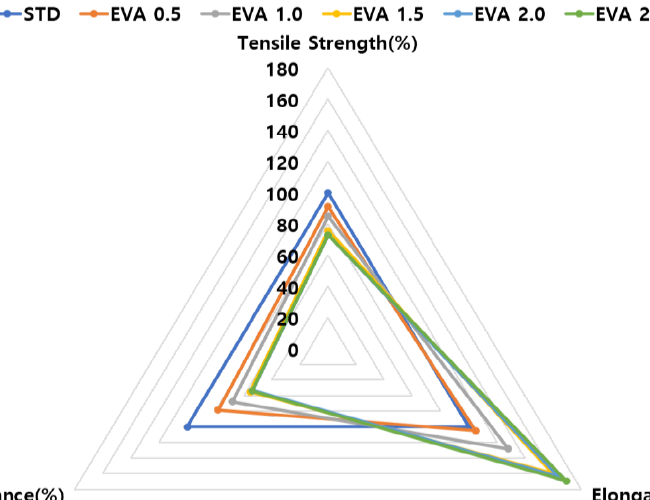
Figure 10. Strength increase/decrease rate according to NF input.